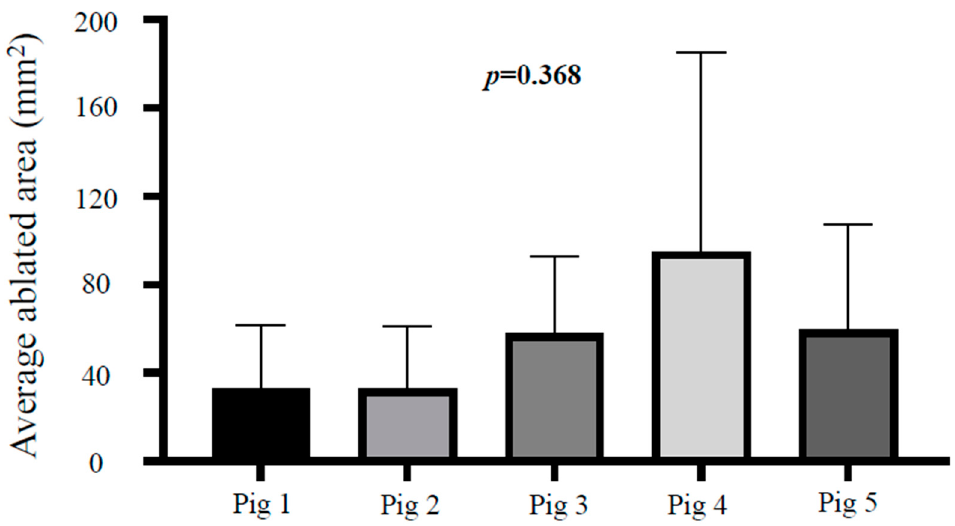
Figure 5. Average fibrosis area after EUS-CILA Mean ablated areas in the pancreatic sections of the five pigs were not significantly different ( p = 0.368).